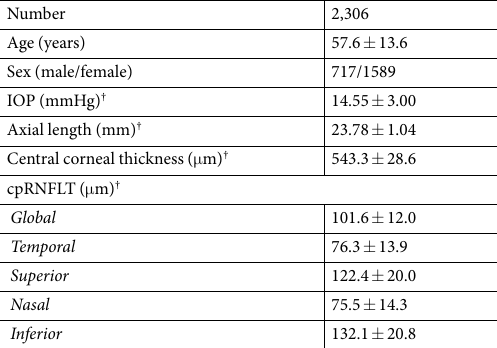
Table 1. Demographics of study participants. Data represent the mean ± SD. IOP, intraocular